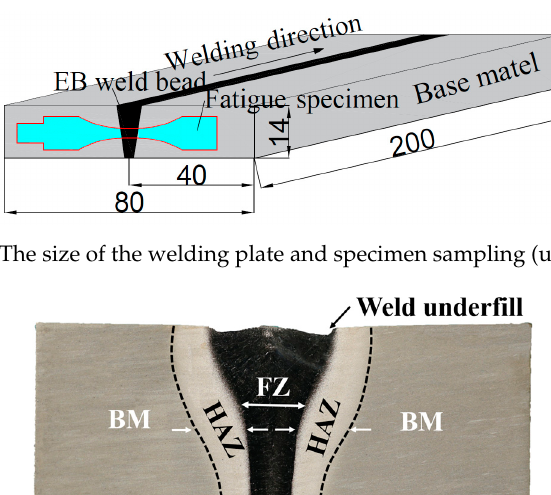
Figure 2. Macrostructure of electron beam welding (EBW) joint of TC17 titanium alloy.